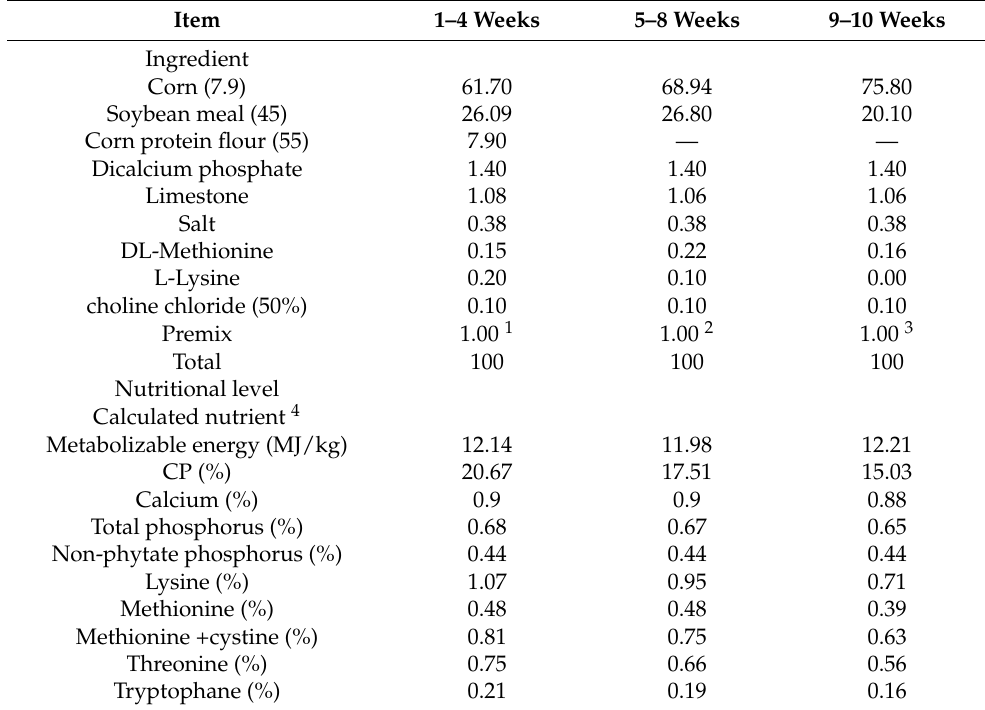
Table 1. Ingredient composition and nutrient content of the basal diet (%, as-fed